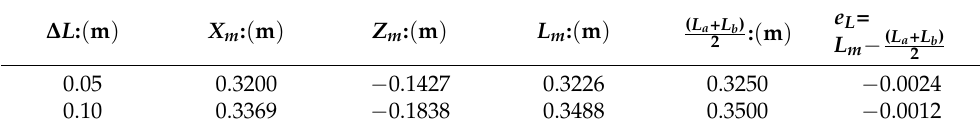
Table 5. The length of assumed backbone in difference ∆ L (data from experiment, L b = 0.30 m).